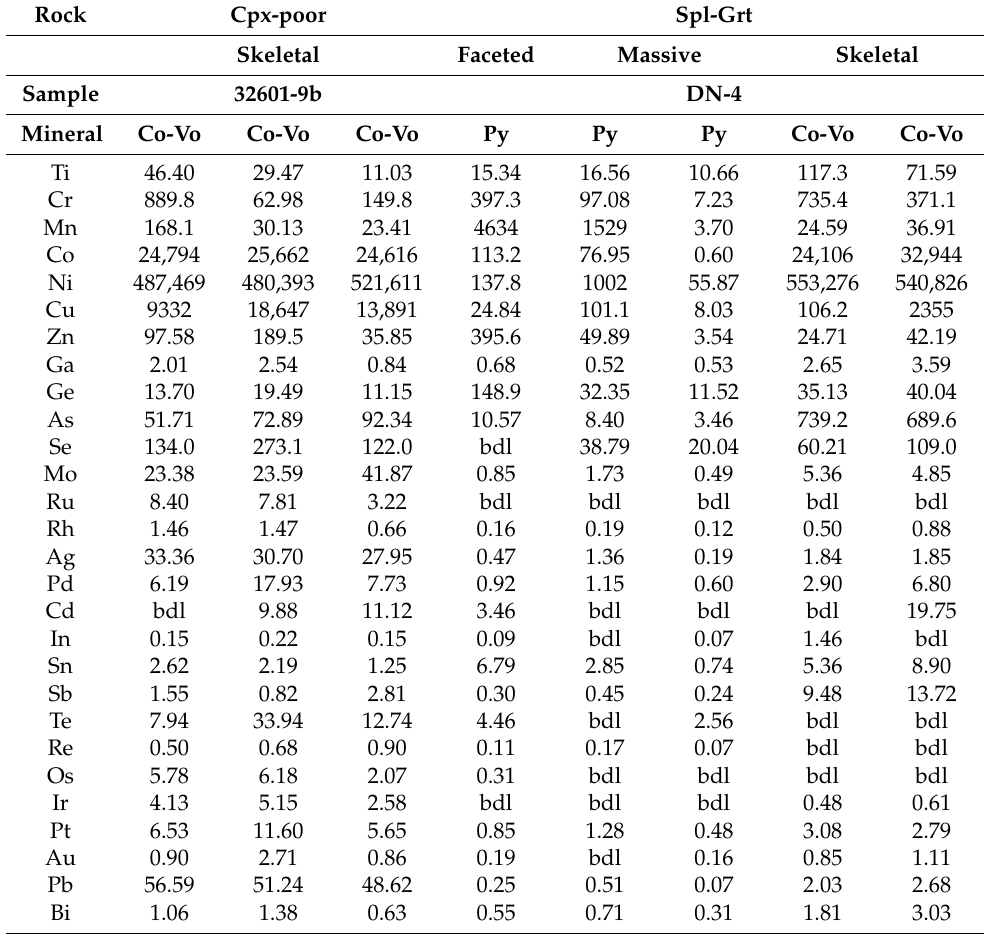
Table 6. Trace-element characteristics of m-type sulfides in lherzolites from East Antarctica (ppm). Rock